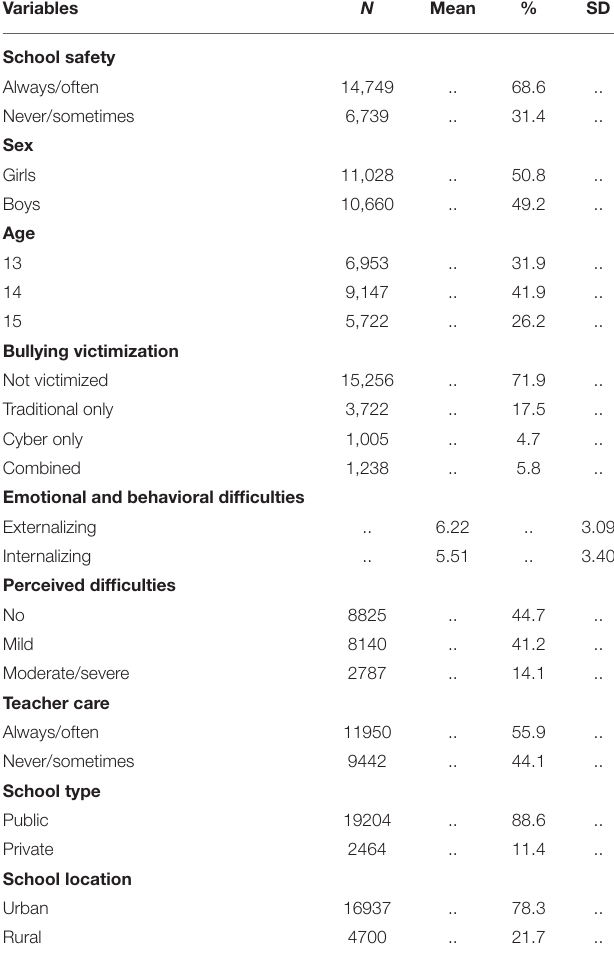
TABLE 2 | Summary of responses and explanatory variables in the 13 participating